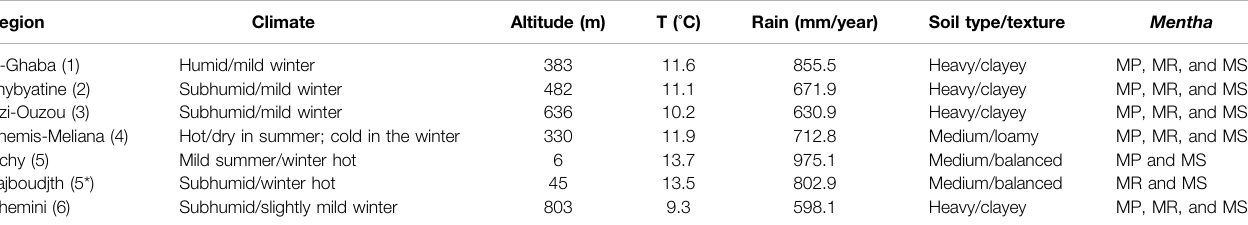
TABLE1| Climate,altitude,averagetemperature,rain,andsoilcharacteristicsofthegrowthregionsofthethree Mentha species[ M.pulegium (MP), M.rotundifolia (MR),and M. spicata (MS)]. Region Climate Altitude